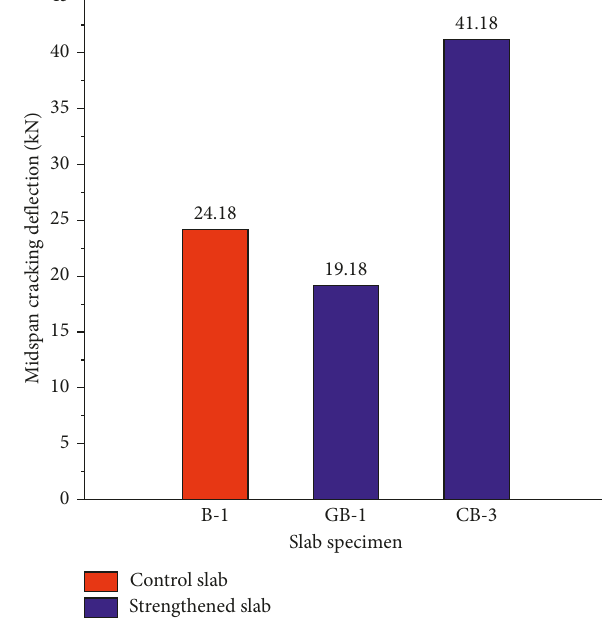
Figure 45: Cracking load.